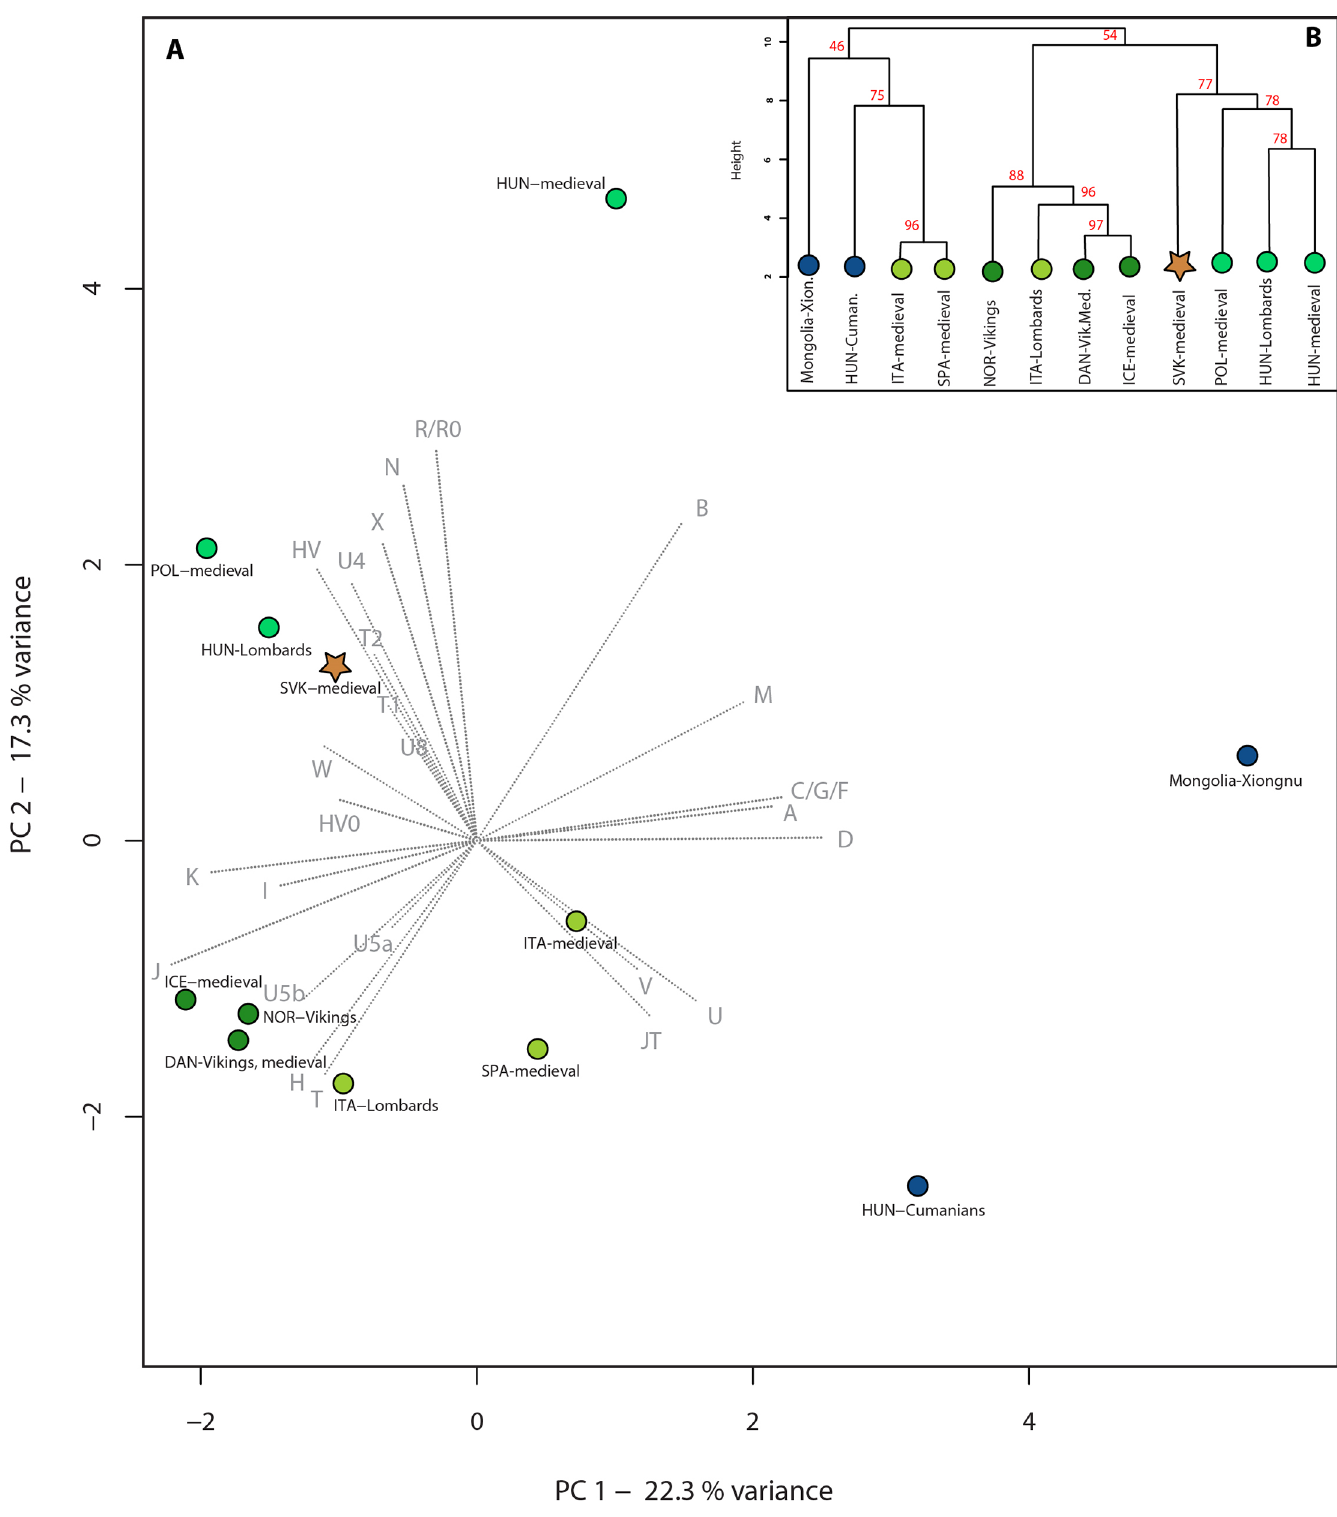
Fig 3. PCA and hierarchical clustering of medieval populations. PCA (A) and hierarchical clustering (B) based on mtDNA haplogroup frequencies of 12 medieval populations show a clustering of medieval populations from Slovakia (SVK-medieval), Lombards from Hungary (HUN-Lombards) and a medieval population from Poland (POL-medieval). The medieval populations and the Vikings of North Europe are clustered together, as are the medieval populations from South Europe. The index of abbreviations is in S7 Table.